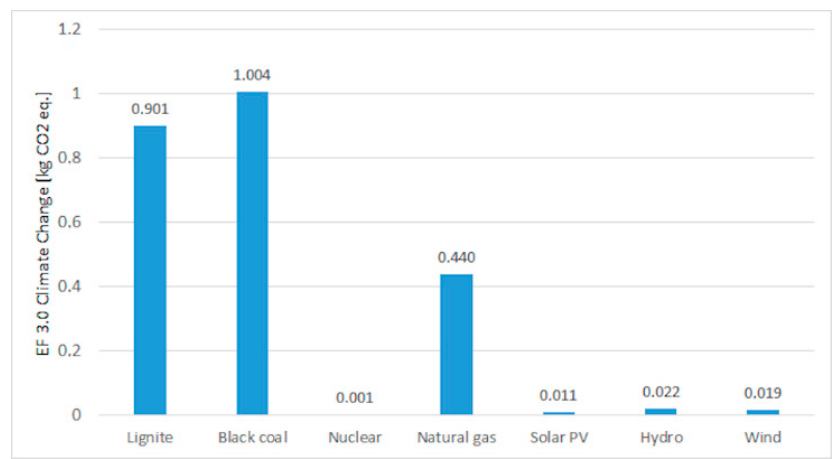
Figure 2. Environmental impacts of selected types of energy sources on the climate change category. The results are related to 1 kWh of electricity supplied to the grid. The results are expressed in kg CO 2